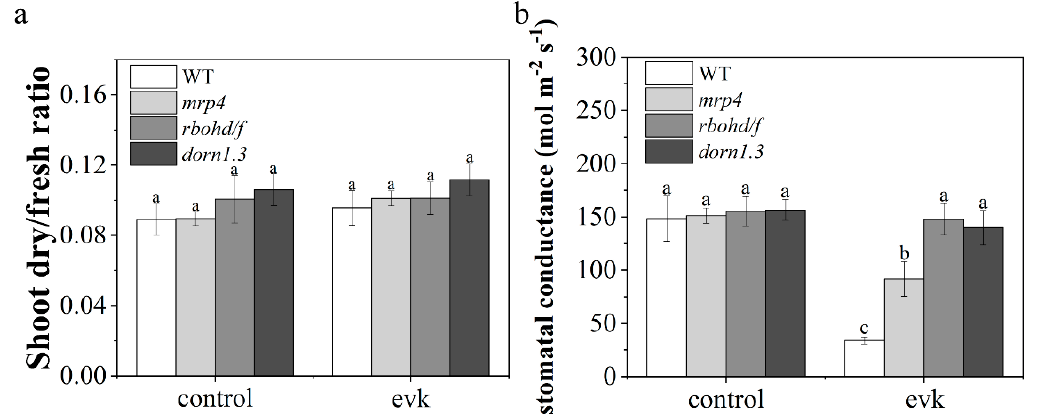
Figure 7. ( a ) The ratio of fresh weight to dry weight. In the WT control group, Arabidopsis plants were treated with ethyl alcohol fumigation, and in the WT evk group, Arabidopsis plants were treated with evk fumigation at 8 µ M final concentration. Error bars denote ± SEM (standard error of mean), n = 6–8, p < 0.05, means labeled with different letters are significantly different at p < 0.05, Dunnett’s C (variance not neat). ( b ) Stomatal conductance in WT, mrp4, rbohd/f, and dorn1.3 plants before and after evk treatment for 1 h. The stomatal conductance was monitored with a diffusion porometer. The vertical scale represents the stomatal conductance before and after evk treatment. Data were obtained from at least 20 leaves from different Arabidopsis plants; bars represent the standard error of the mean.